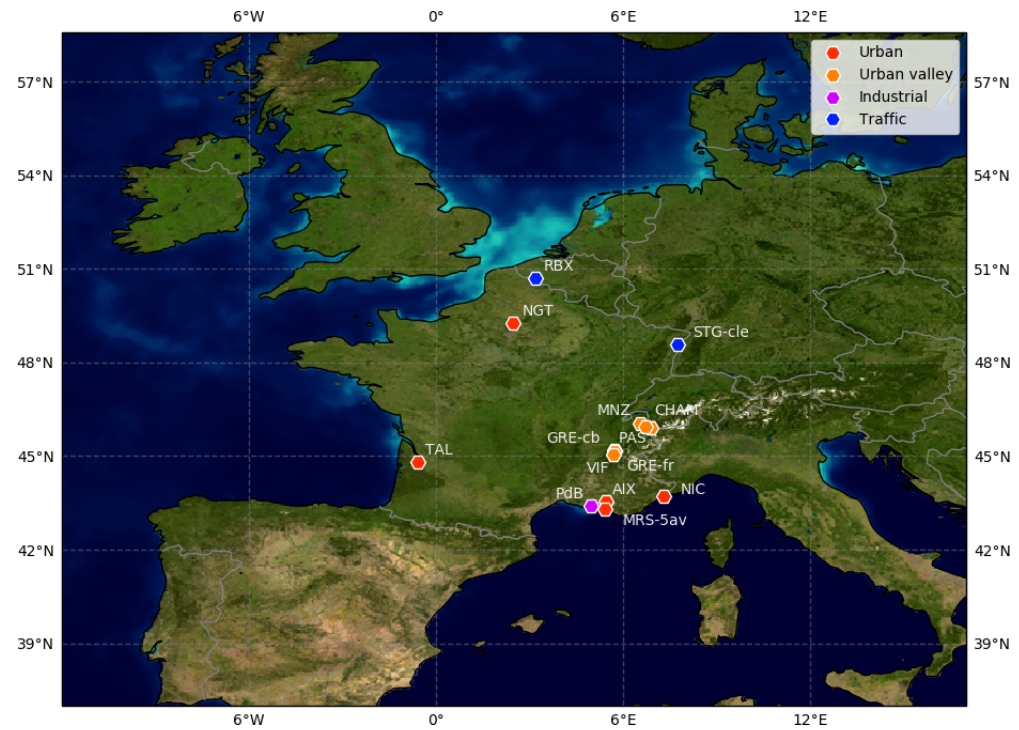
Figure 1. Locations of the 14 sampling sites. Color codes denote the typologies of the sites: red, urban; orange, urban valley; magenta, industrial; blue, traffic. Background photography from NASA’s Earth